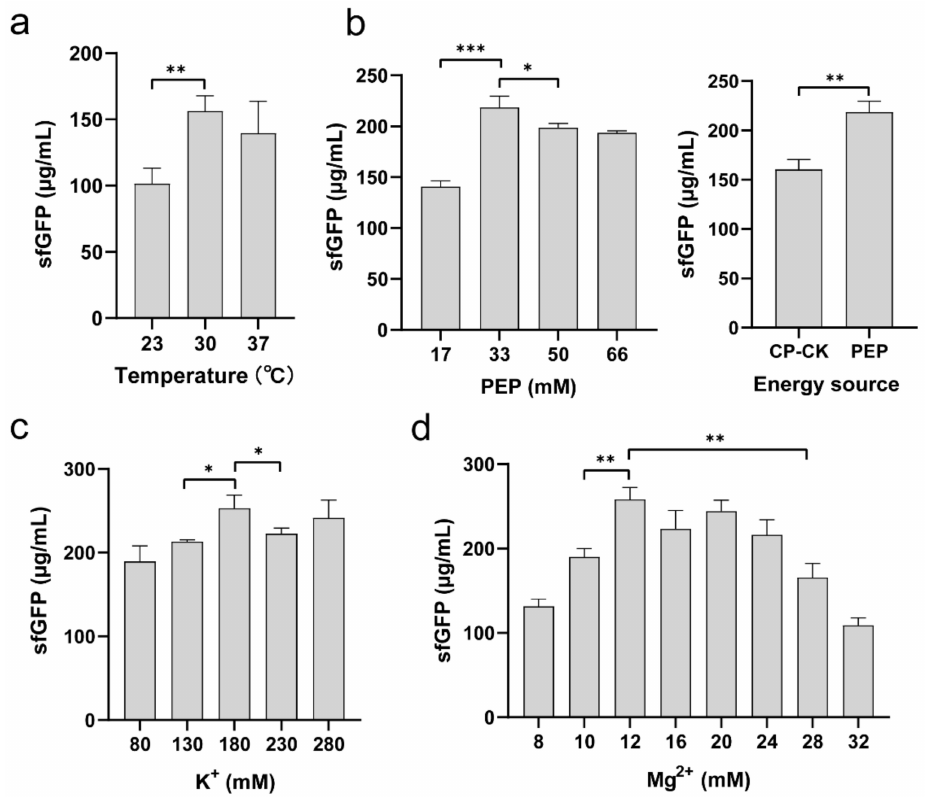
Figure 4. Optimization of CFPS reaction conditions. ( a ) Effect of reaction temperature on the sfGFP yield. ( b ) Effect of PEP concentration ( left ) and different energy regeneration systems (CP/CK and PEP, right ) on cell-free synthesis of sfGFP. Optimization of ( c ) K + and ( d ) Mg 2+ concentrations in K. pneumoniae CFPS reactions. Values show means with error bars representing standard deviations (s.d.) of at least 3 independent experiments. Student’s t -tests were used for statistical analysis, and p < 0.05 indicated statistical significance (* p < 0.05, ** p < 0.01, and *** p <